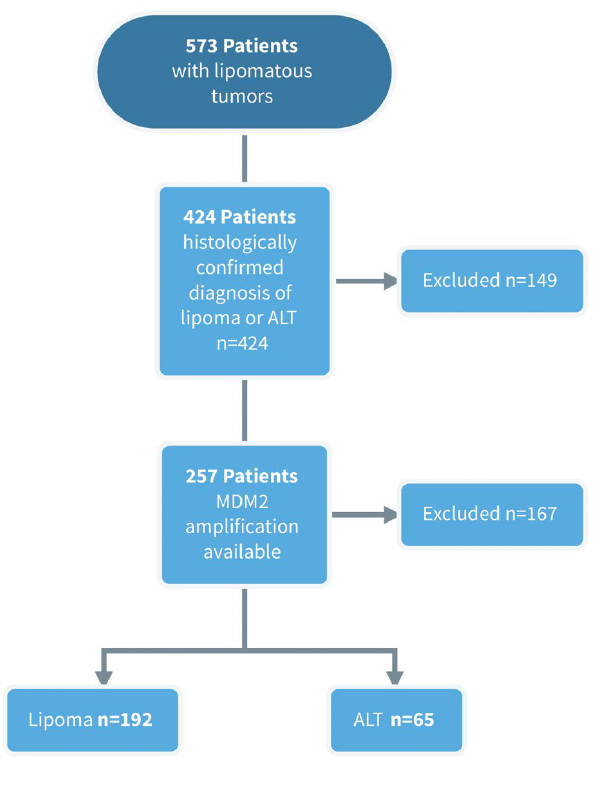
Figure 1. Subject selection flowchart. ALT = atypical lipomatous tumor; MDM2 = murine double minute.